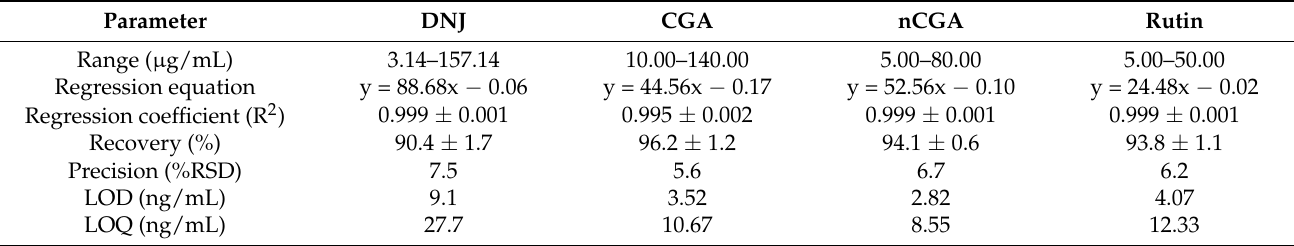
Table 1. Validation metrics of RP-HPLC